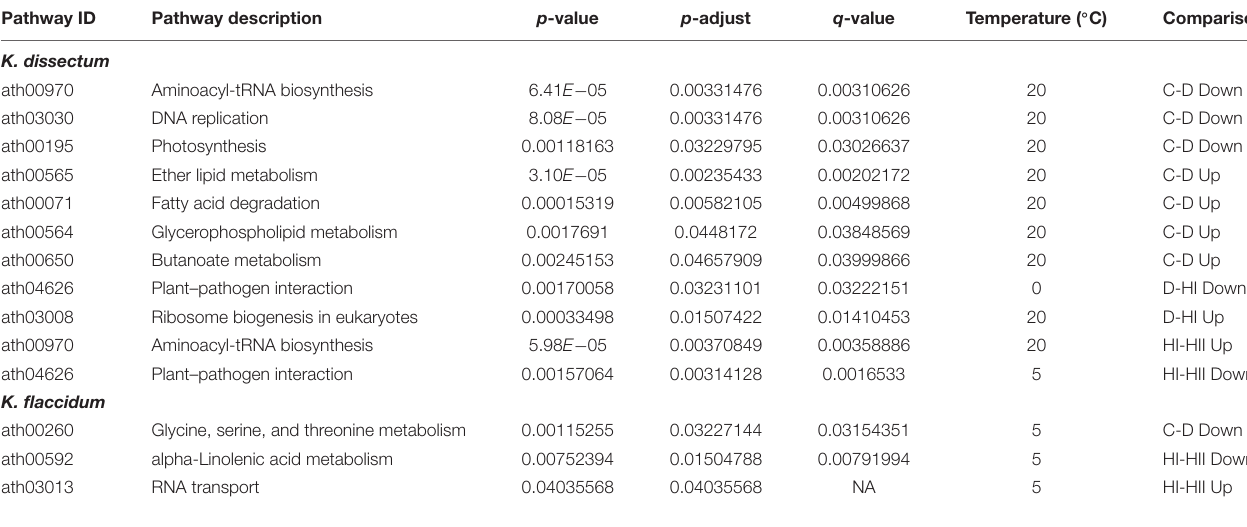
TABLE 2 | A KEGG pathway enrichment analysis based on KO annotations was performed for the up- and downregulated transcripts in all analyzed groups using the ath_pathway map at KEGG. Pathway ID Pathway